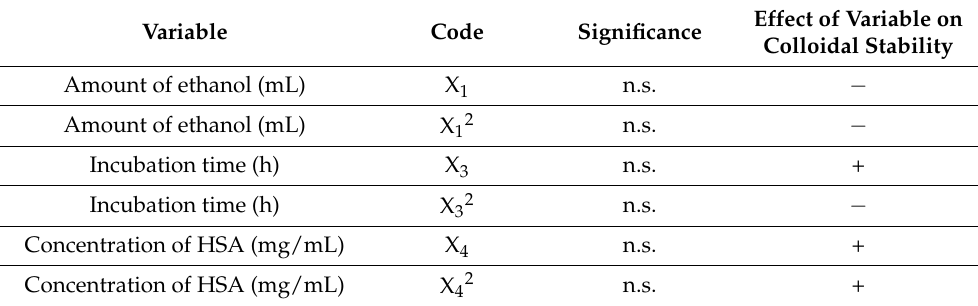
Figure 5. Response surface showing the effects of the amount of ethanol (X 1 ) and the concentration of HSA (X 4 ) at the mid-level of incubation time (X 3 ) on the PdI (Y 2 ). Based on the R 2 (0.53895) and adjusted R 2 (0.19316) of the surface plot that was results (Table 11). Table 11. Effect of the selected process and material parameters on the zeta potential of HSA nanoparticles produced by the rapid coacervation method. Statistical analysis: One-way ANOVA, α = 0.05. (n.s. means non-significant